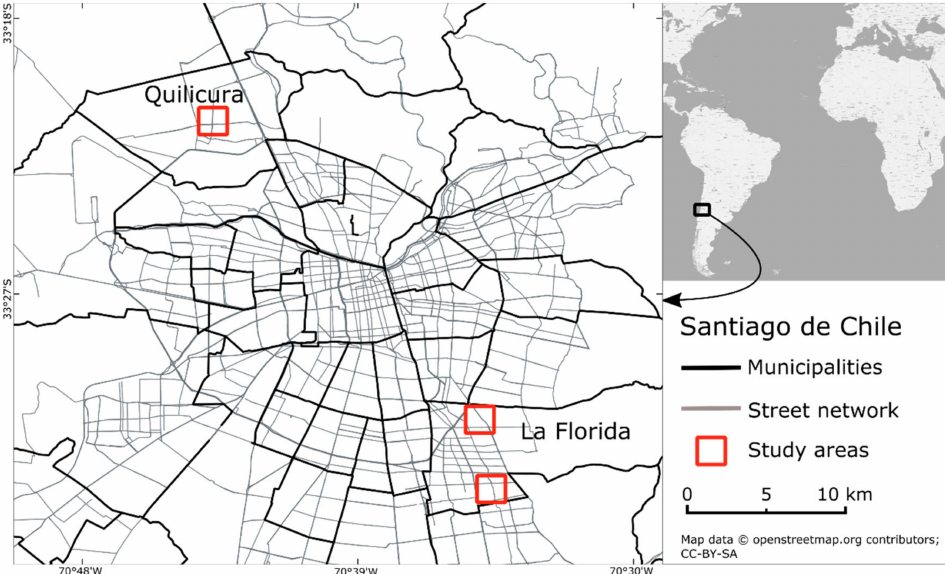
Figure 3. Santiago de Chile with its municipalities of Quilicura (first case study in 2015), and La Florida (second case study in 2016 with a study area in the north and the south,